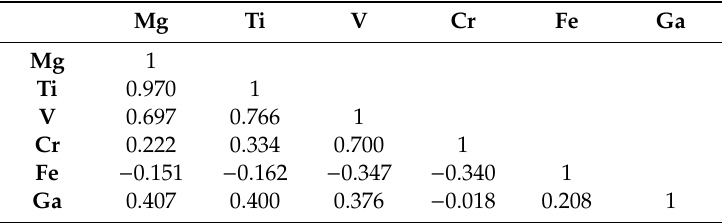
Table 11. Correlation table for trace elements of Yogo blue and violet sapphires and rubies. Mg Ti V Cr Fe Ga Mg 1 Ti 0.956 0.665